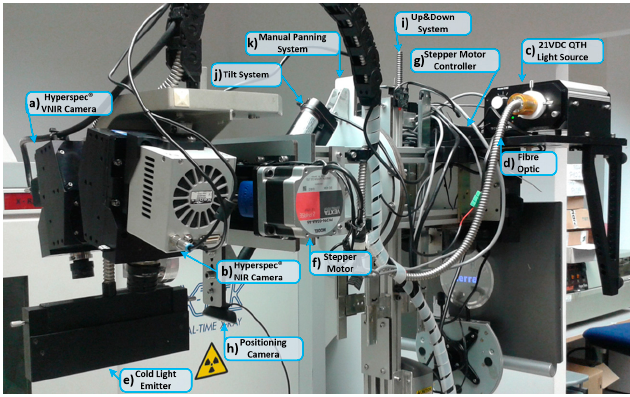
Figure 2. The HELICoiD demonstrator acquisition platform. ( a , b ) VNIR and NIR HS cameras mounted on the scanning platform; ( c – e ) QTH light source connected to the fiber optic system for the light transmission to obtain cold light emission in the scanning platform; ( f , g ) Stepper motor coupled to the spindle and connected to the stepper-motor controller to perform the linear movement of the cameras; ( h ) Positioning of the RGB camera used to identify the position of the cameras’ field of view (FOV); ( i ) The Up&Down system used to focus the HS cameras; ( j ) and ( k ) Tilt and manual panning systems employed to correctly orientate the scanning platform.